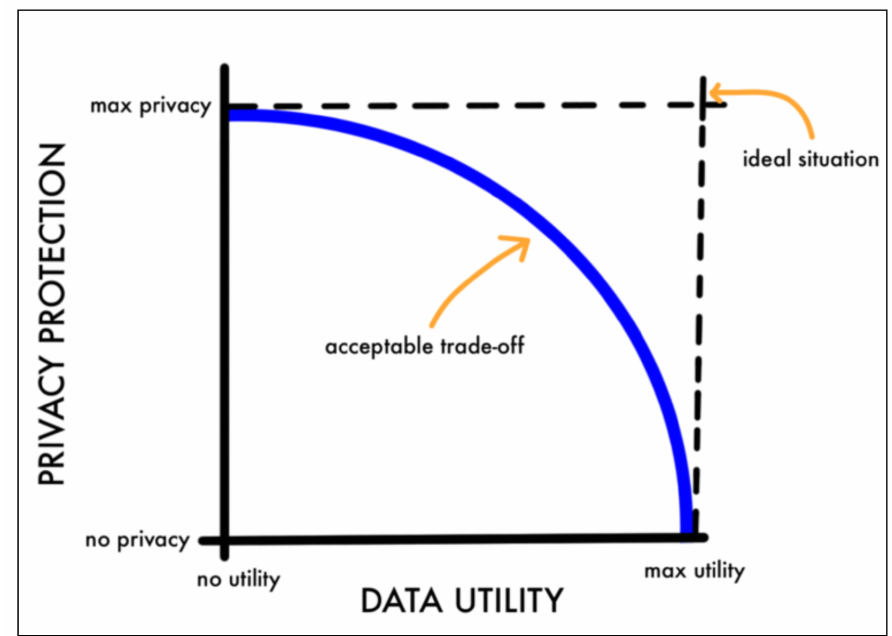
Figure 2. Trade-off between privacy and